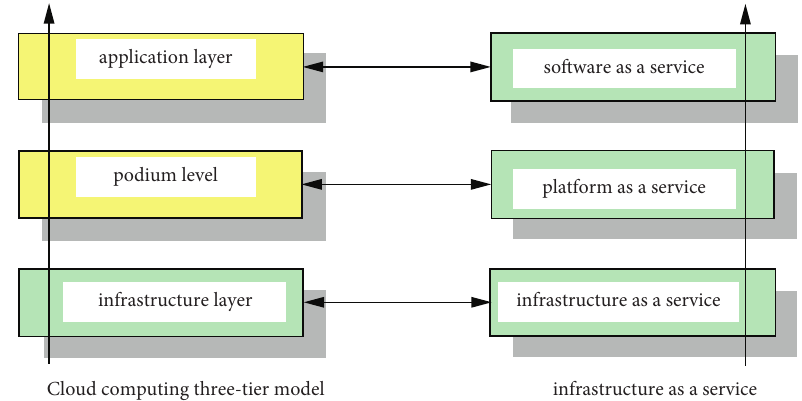
Figure 1: Cloud computing system model